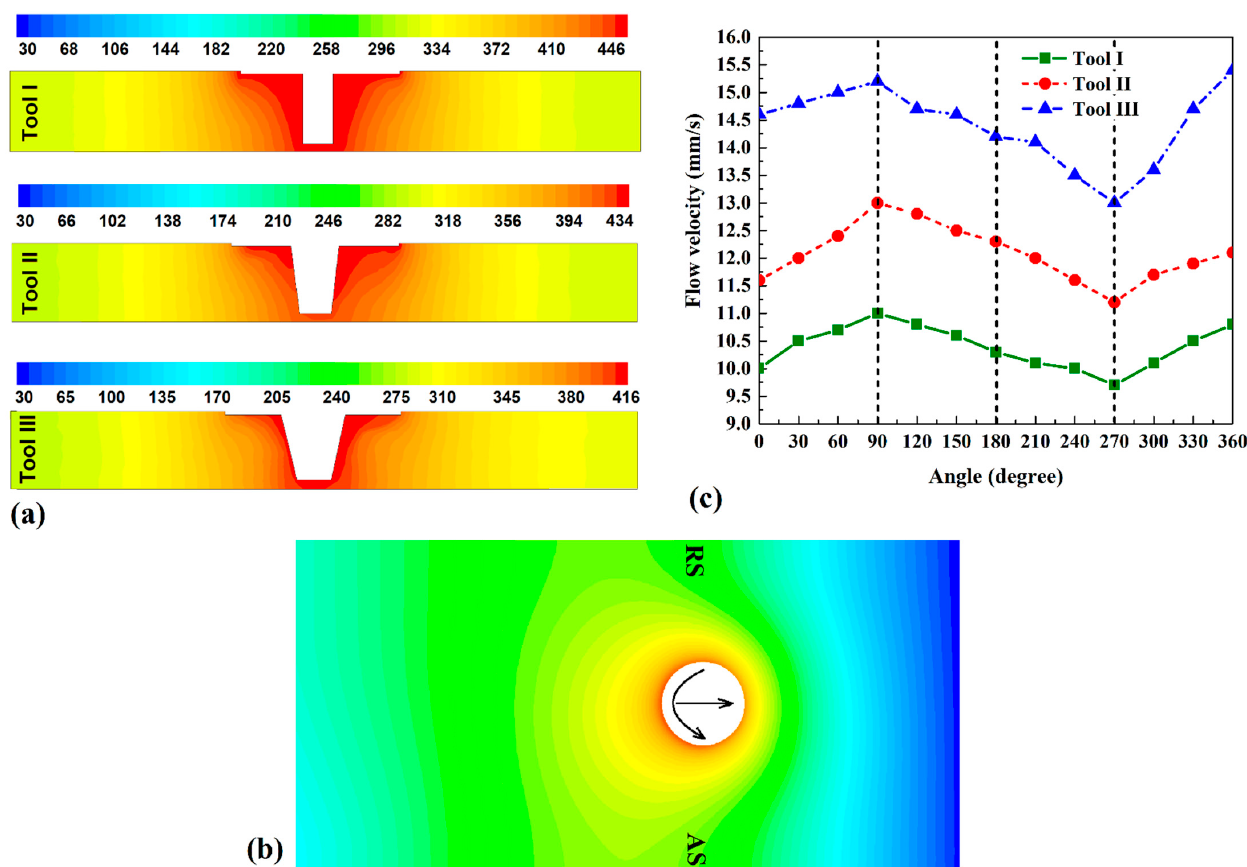
Figure 5. ( a ) internal heat distribution of various tools, ( b ) surface heat flow of joint that FSWed with tool III, ( c ) materials viscosity around various tool pin.